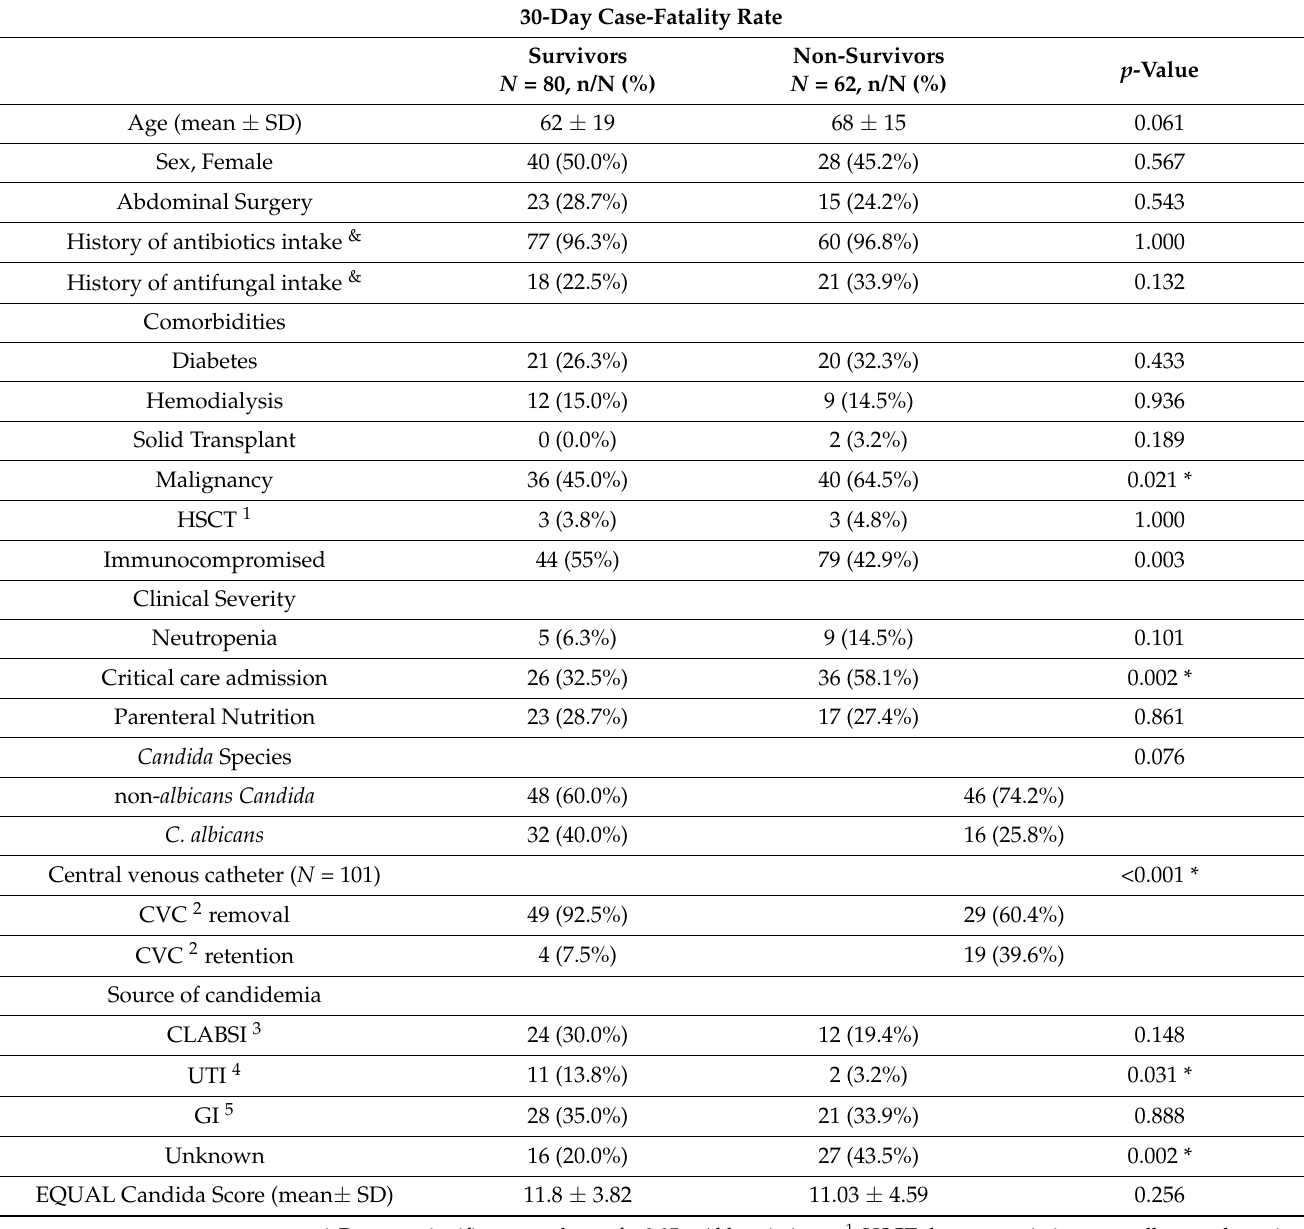
Table 3. Comparative characteristics of the 142 cases of candidemia stratified by case-fatality